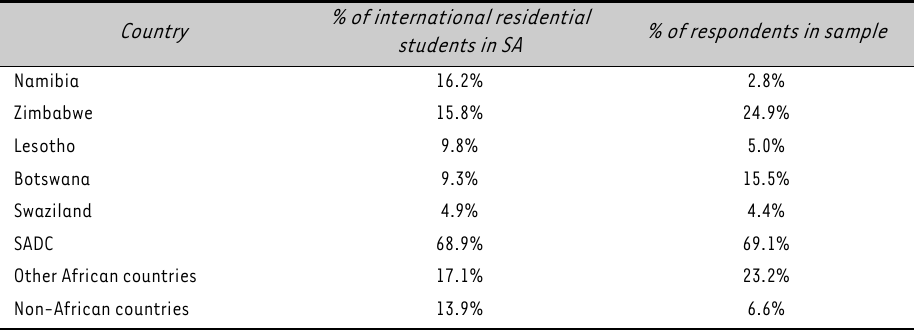
Table 3: Source countries of respondents